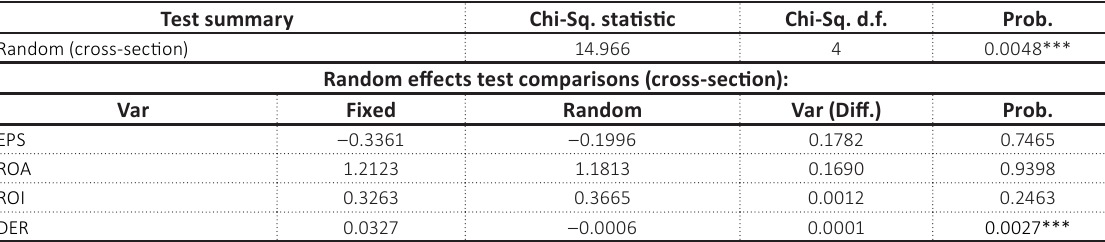
Table 5. Hausman test (correlated random effects) Test